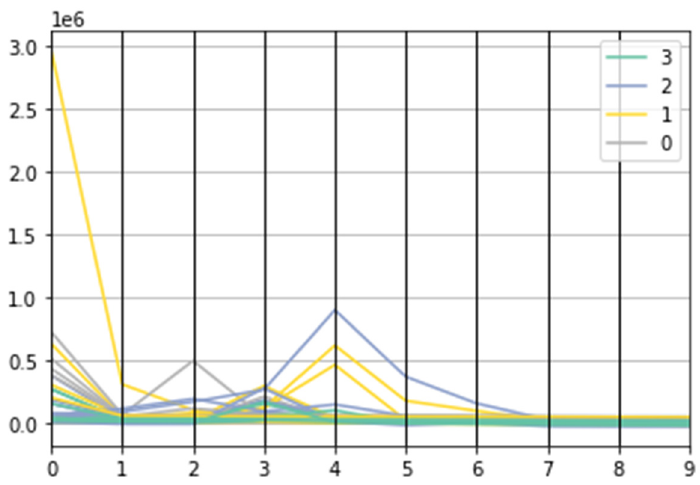
Figure 5. Parallel coordinates plot.